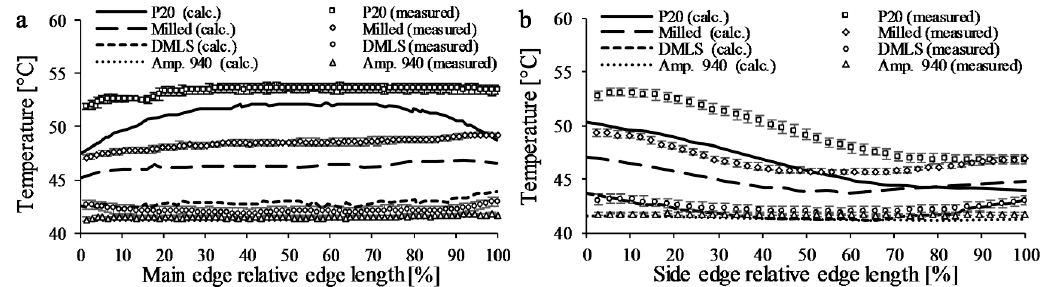
Figure 7. The measured and calculated surface temperature near ( a ) the main edge and ( b ) the side edge of the investigated inserts.